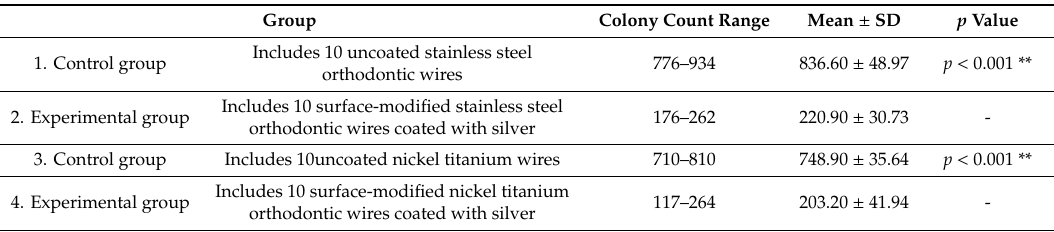
Table 3. Groups of archwires used for antibacterial property of surface modified orthodontic archwires and comparison of colony count